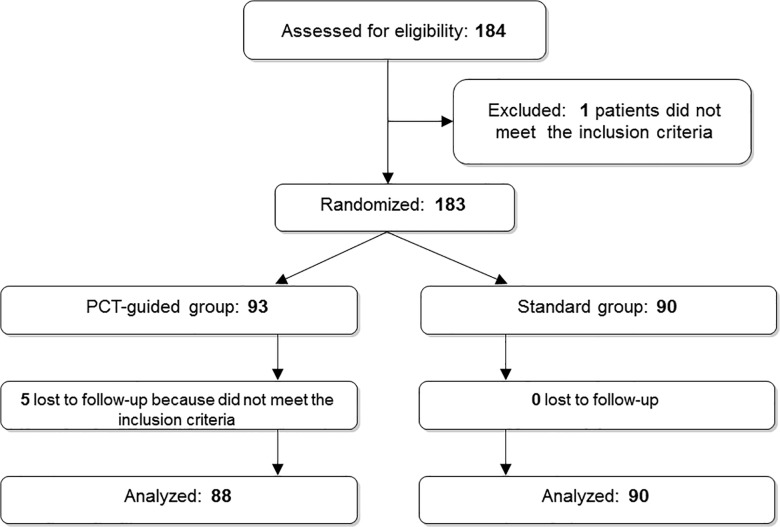
Trial profile: screening, enrollment, randomization, and follow-up.